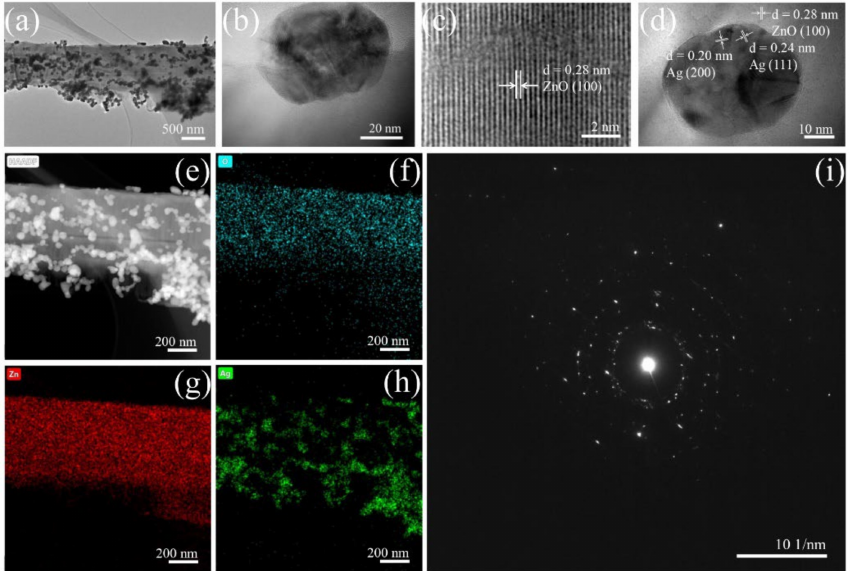
Figure 4. ( a ) TEM micrograph of ZnO/Ag2. ( b – d ) HRTEM micrograph of ZnO/Ag2. ( e ) STEM micrograph of ZnO/Ag2. ( f – h ) Elemental mappings of O, Zn, and Ag. ( i ) SAED pattern of